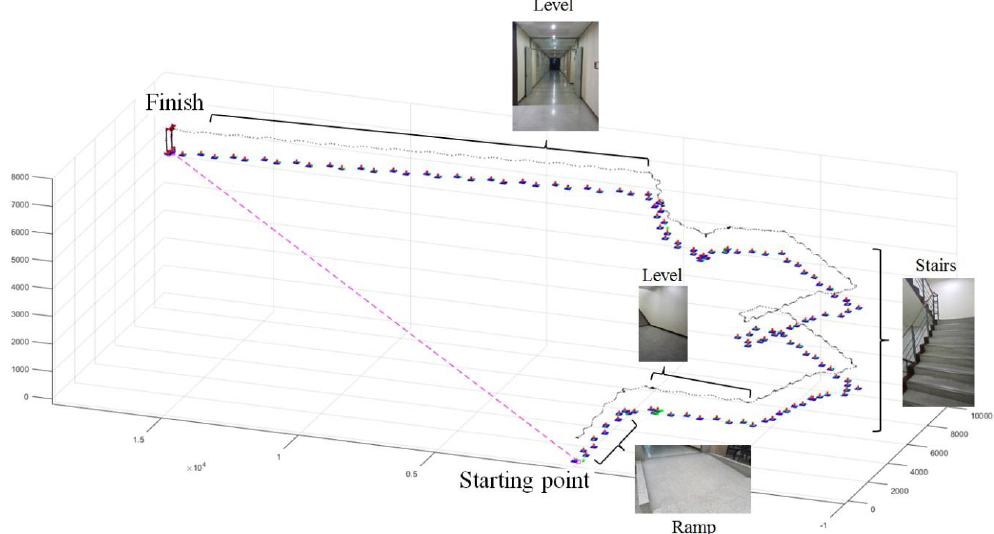
Figure 25. Test result for the motion of the exoskeleton in a building environment. (The video showing the analysis results of this test can be found in Supplementary Materials Video S2).